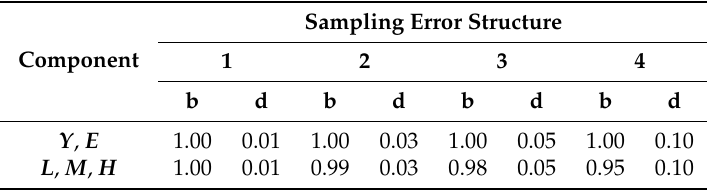
Table 2. Mean (b) and standard deviations (d) of the normal random variates used to simulate